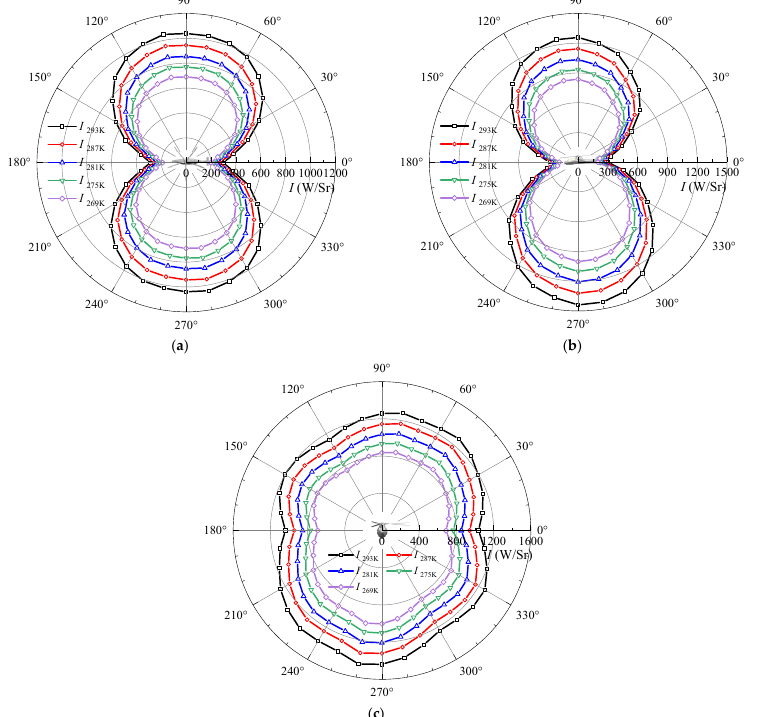
Figure 12. Infrared radiation intensity of the helicopter in 8–14 µm band. ( a ) XOY circle; ( b ) XOZ circle; and ( c ) YOZ circle. From the above research, we can a tt ain that the high temperature area and strong infrared radiation source of the helicopter exist on the rear fuselage surface and the ex- haust port at the bo tt om of the rear fuselage. If the temperature of the rear fuselage surface can be suppressed, and the exposure of the exhaust port can be reduced, the infrared stealth performance of the helicopter can be further improved. Therefore, for the high- temperature components of the helicopter, three projects are proposed to suppress its in- frared radiation, that is, reducing the emissivity of the fuselage surface, assembling a shielding sheath for the mixing duct, and shielding the exhaust port of the fuselage, which will be discussed in the following sections.